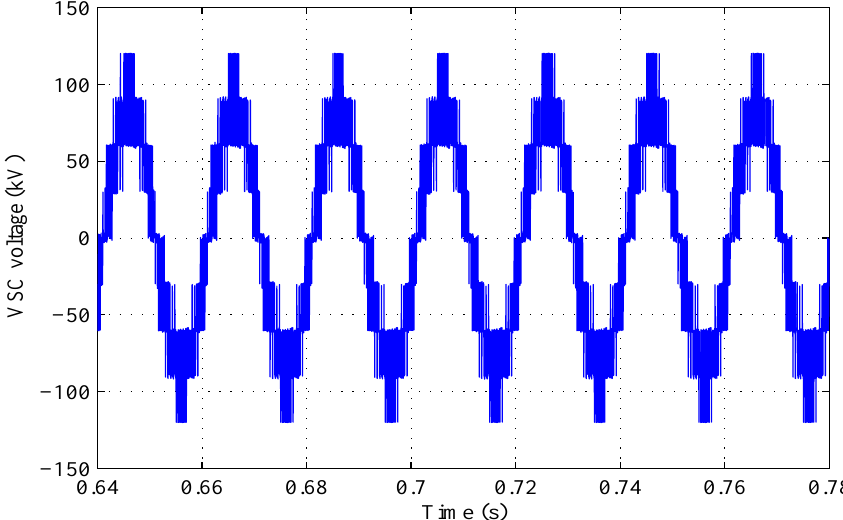
Line-to-line output voltage of the five-level flying-capacitor (FC) VSC t 0 . 78 ( 0 . 64 s ≤ ≤